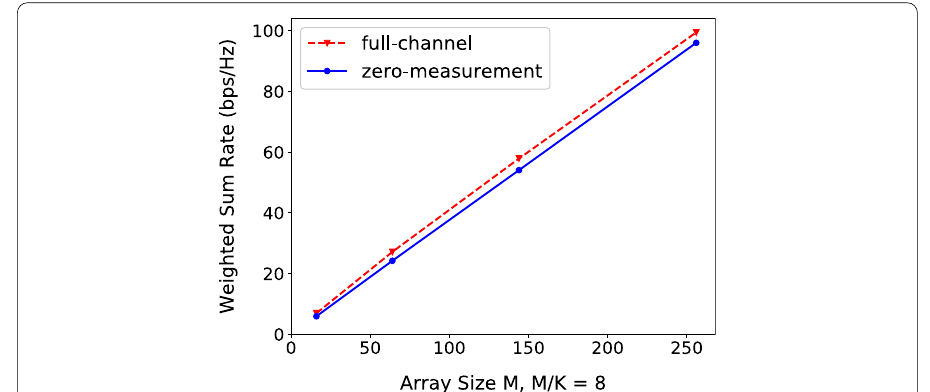
Fig. 11 The weighted sum rate with zero-measurement selection and full-channel selection, respectively. The system setup is that where a changing number of antennas select changing number of users with fixed ratio as 8 out of 100 users for downlink beamforming based on simulated